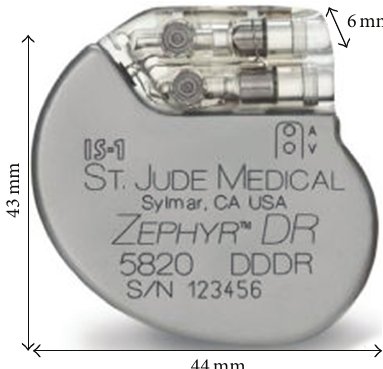
Figure 4: Typical sizes of a cardiac pacemaker.